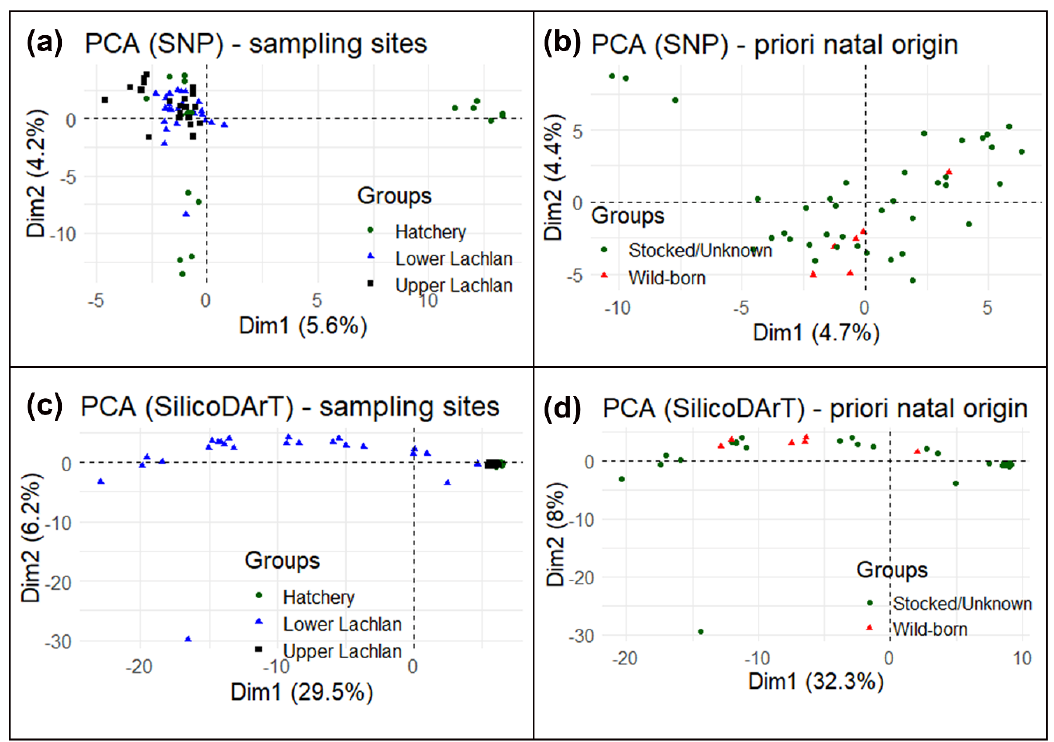
Figure 5. Principal component analysis (PCA) of M. ambigua ; ( a ) PCA plot using Single Nucleotide Polymorphism markers—plotting based on geographic locations such as lower Lachlan, Upper Lachlan, and Hatchery; ( b ) PCA plot of only Lachlan samples using Single Nucleotide Polymorphism markers— plotting based on natal origins such as wild-born fish and hatchery-bred stocked / unknown-source fish; ( c ) PCA plot using SilicoDArT markers–plotting based on geographic locations such as Lower Lachlan, UpperLachlan, andHatchery; ( d )PCAplotofonlyLachlansamplesusingSilicoDArTmarkers—plotting based on natal origins such as wild-born fish and hatchery-bred stocked / unknown-source